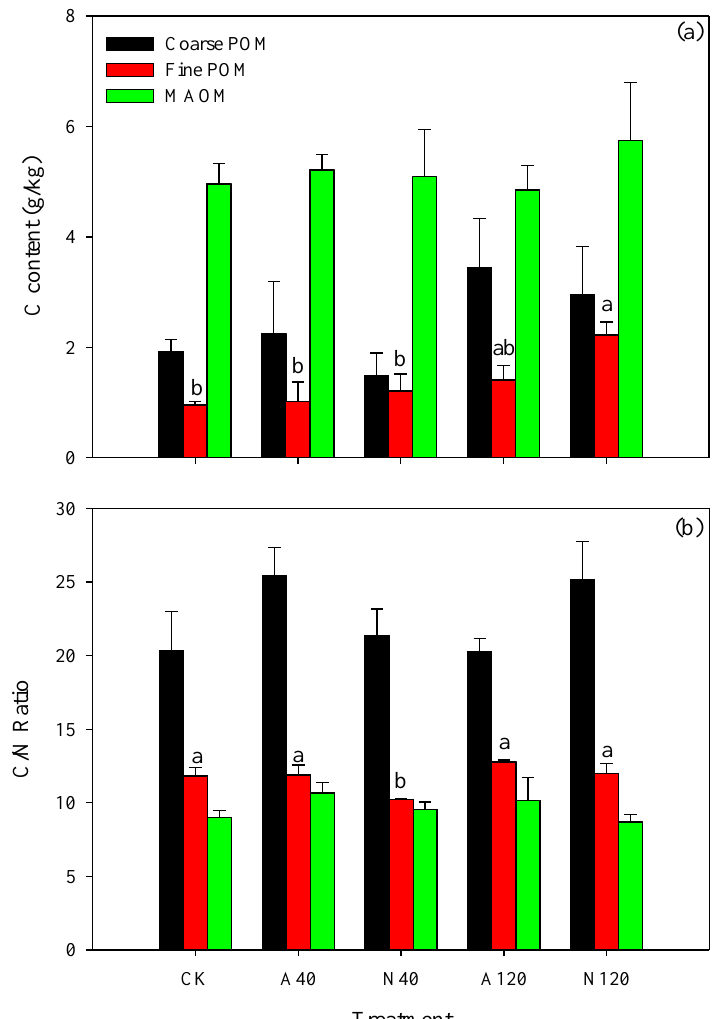
Figure 2. Soil C contents ( a ) and C:N ratios ( b ) of three fractions under different treatments. CK, A40, A120, N40, and N120 are control, low (40 kg N ha −1 yr −1 ), and high (120 kg N ha −1 yr −1 ) rates of NH 4 Cl and NaNO 3 application, respectively. Error bars represent the standard errors of the means ( n = 3). Different lowercases above the columns represent significant differences between control and N treatments.